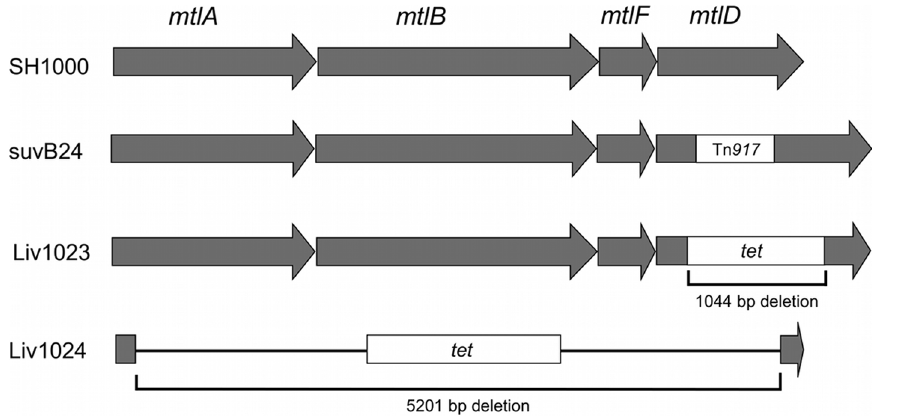
Figure 3. Schematic representation of the mtlABFD locus. Position of the transposon insertion and allelic replacements created during this study.